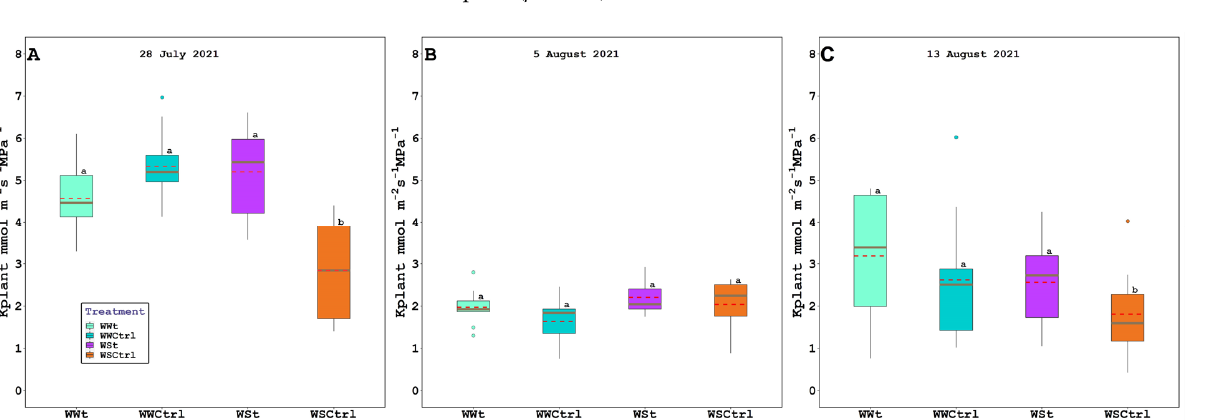
Figure 4. Net photosynthesis (PN; µmol m − 2 s − 1 ) in Vitis vinifera (Pinot Noir cv.) treated with Zeolite (t) and untreated plants (Ctrl), under two irrigation regimes (WW, well-watered; WS, water- stressed); ( A ). 28 July 2021, ( B ). 5 August 2021, and ( C ). 13 August 2021. The box bounds show the 25 and 75 percentiles, and the error bars the 90 and 10 percentiles. The black continuous and red discontinuous lines inside the boxes represent medians and means, respectively. Outliers are represented as color dots. Average values with the same letter in each figure indicate no significant differences between plots ( p < 0.05).